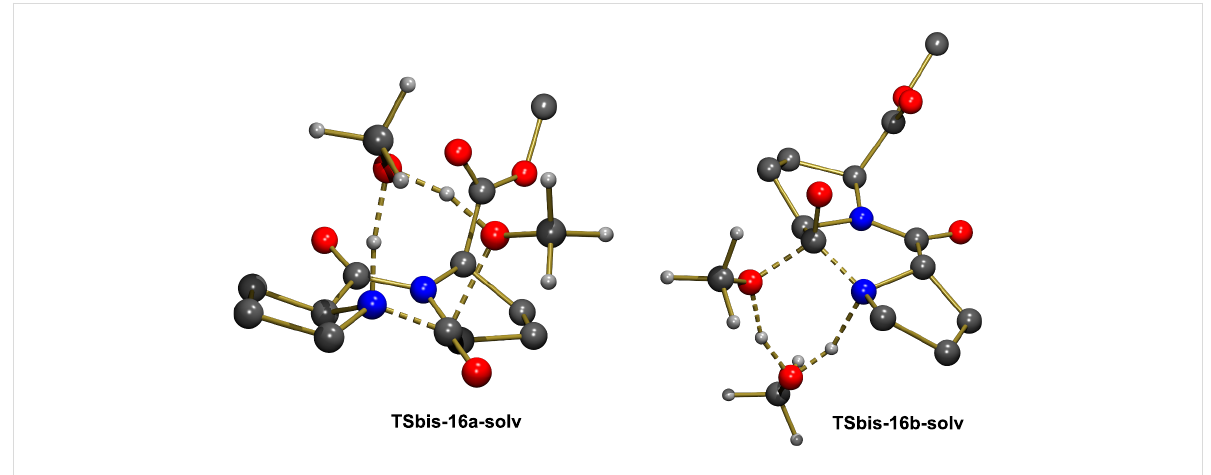
Figure 4: Optimized geometries for the transition states associated to alternate position of the methanol molecule. Most H atoms were omitted for clarity.